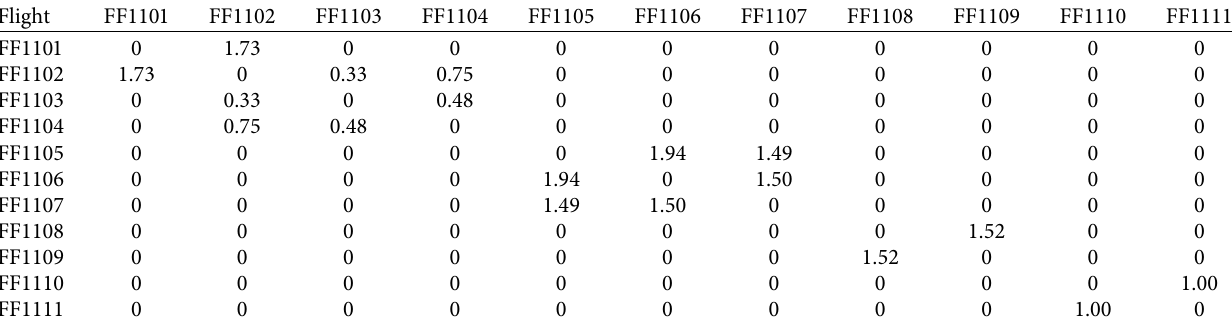
Table 2: Interfight relationship adjacency